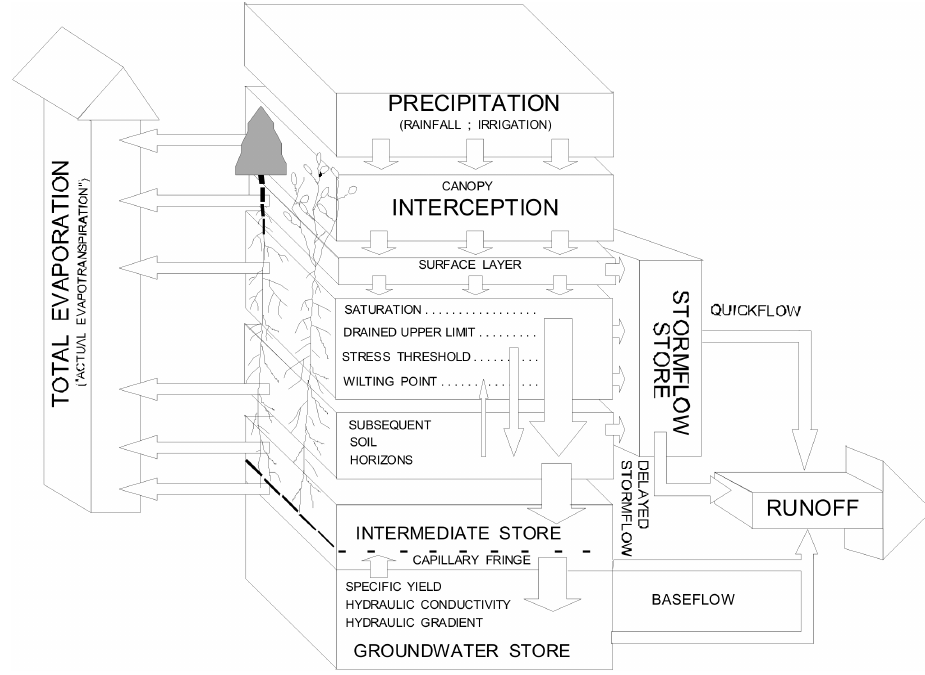
Fig. 1. Representation of the water budget in the ACRU model (Schulze, 1995; Schulze and Smithers,